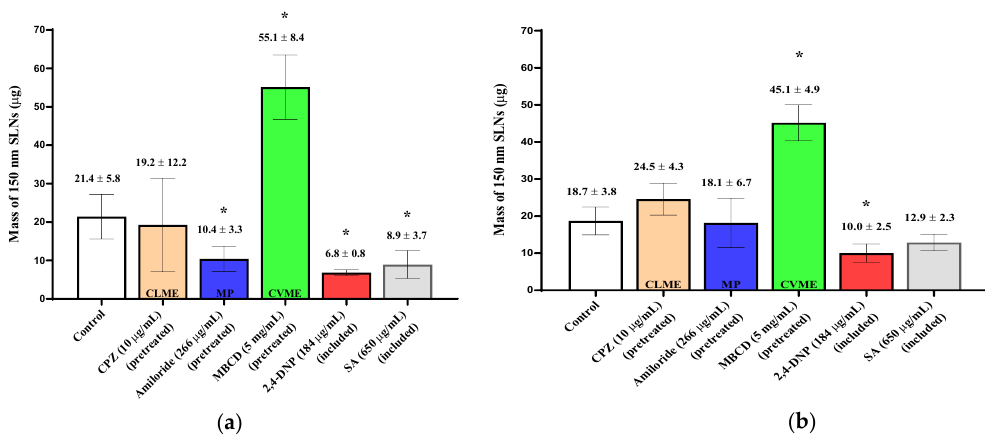
Figure 2. Uptake (30 min) of 150 nm SLNs in the nasal olfactory ( a ) and respiratory ( b ) tissues pre-treated with endocytic inhibitors. 2,4-DNP and sodium azide were also included with the SLNs. Bar graphs display mean nanoparticle uptake ± standard deviation determined from the recovery of Nile Red from the tissues. Statistical comparisons were made between each of the inhibited tissues and the control tissues using Student’s two-tailed t -test ( p < 0.05). * denotes a statistical difference between the inhibited and control tissues.